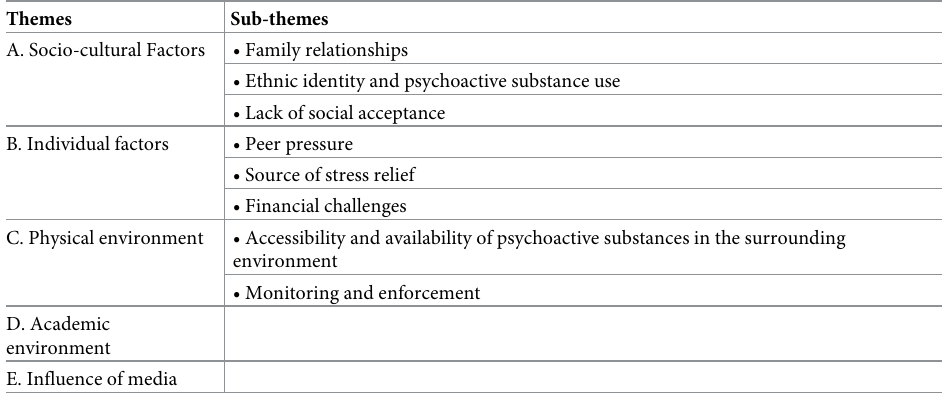
Table 1. Themes and sub-themes on drivers of psychoactive substance use among Nepalese